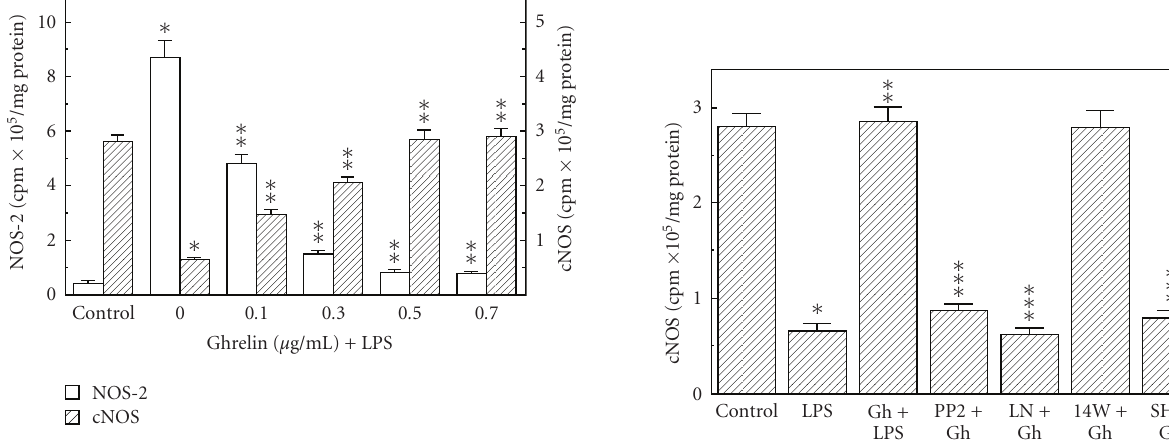
Figure 6: E ff ect of nitric oxide synthase inhibitors on the ghrelin (Gh-) induced changes in cNOS activity in gastric mucosal cell exposed to H. pylori LPS. The cells, preincubated with 30 μ M PP2, 300 μ M L-NAME (LN), 20 μ M 1400 W (14W), or 20 μ M SH-5 (SH), were treated with Gh at 0.5 μ g/mL and incubated for 16 h in the presence of 100ng/mL LPS. Values represent the means ± SD of five experiments. ∗ P < . 05 compared with that of control. ∗∗ P < . 05 compared with that of LPS alone. ∗∗∗ P < . 05 compared with that of